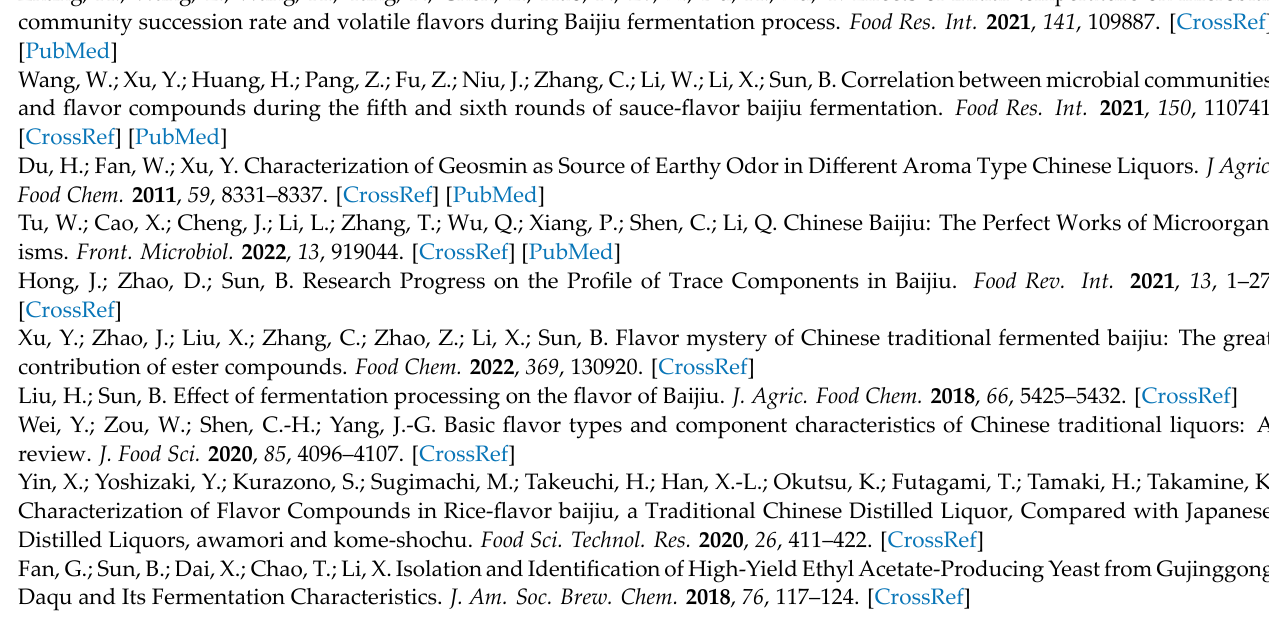
W. anomalus strain YF1503; Figure S1: The changes of ethyl acetate content during different peri‑ ods; Figure S2: Length distribution of the transcripts length; Figure S3: Venn diagram of TF genes under different fermentation times. Venn diagrams showing the total number of significant TFs ( p ‑value ≥ 0.05) at 24 h, 48 h, 72 h, 96 h and 120 h fermentation time compared to 0 h; Figure S4: Heat map of expression profiles of TF genes in Proile148, Proile101 and alcohol acyltransferases in W. anomalus strain YF1503. The color of the bar represents the level of each transcriptʹs expression abundance, with blue being a low level and red indicating a high